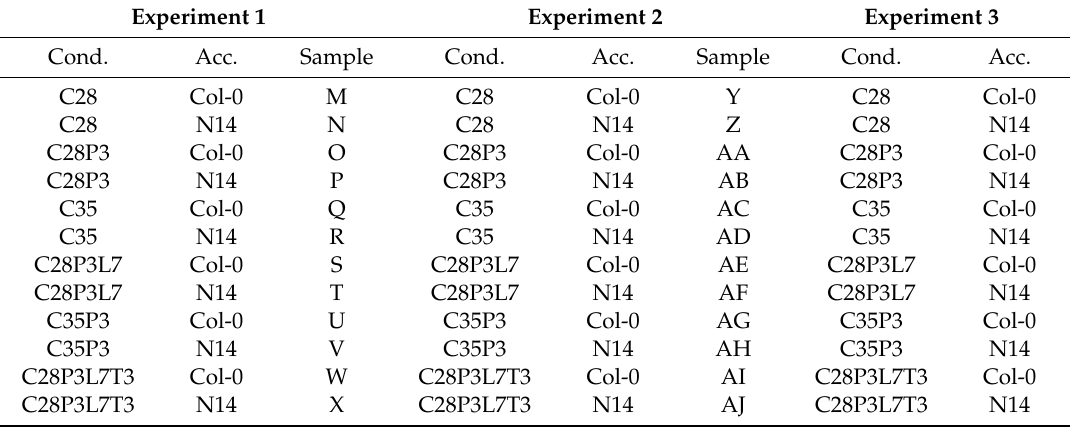
Table A3. Sample list with sample name, condition (Cond.) and accession